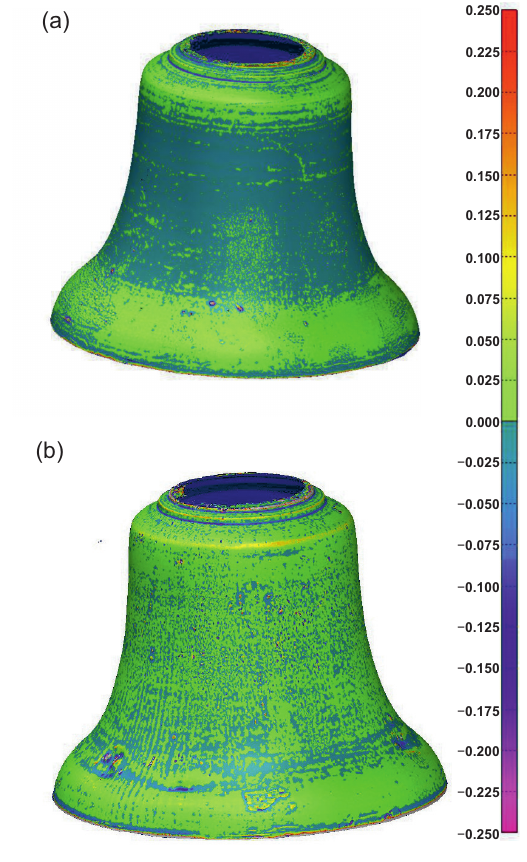
Figure 3. Comparison of the deviations ( mm unit) of the created meshes: ( a ) CuSn20; ( b ) CuAl10Fe3Mn2.